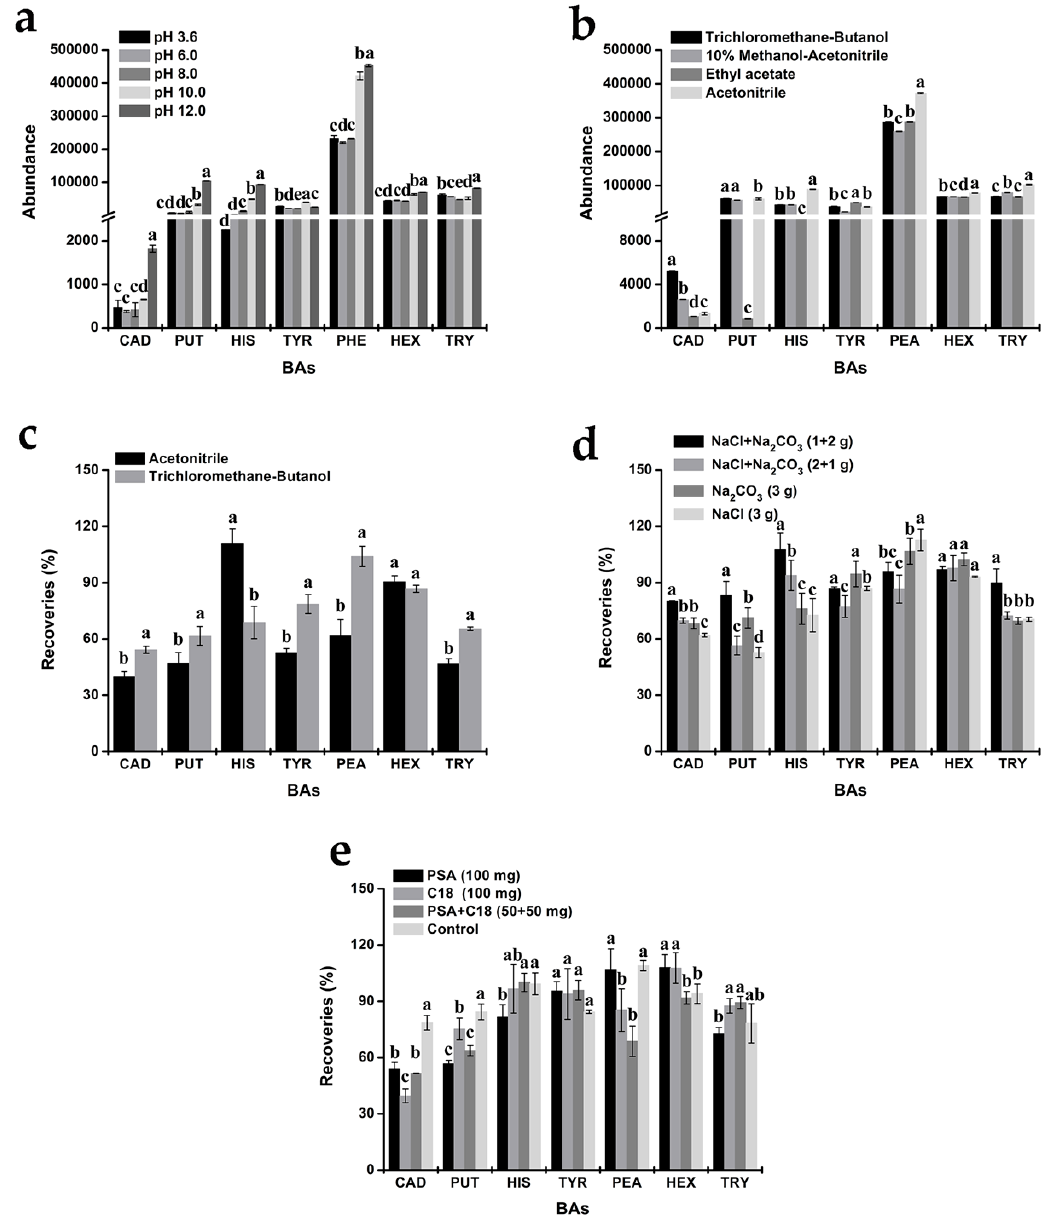
Figure 3. Abundance and recoveries obtained by different QuEChERS procedures ( a ). the pH optimization; ( b ). the extraction solvent optimization; ( c ). the recovery percentage obtained by applying acetonitrile and trichloromethane-butanol solutions; ( d ). the amount and type of salt optimization; ( e ). the clean-up optimization; different letters in same BA are statistically significant p < 0.05; CAD: Cadaverine; PUT: Putrescine; HIS: Histamine; TYR: Tyramine; PEA: Phenylethylamine; HEX: Hexylamine; TRY: Tryptamine). An ideal sample pretreatment way is to use a simple extraction method to distribute the target objects in the extracting solution as much as possible. The extraction e ff ects of acetonitrile, ethyl acetate, trichloromethane-butanol (1:1, v / v ), and 10% methanol-acetonitrile ( v / v ) were compared in this experiment. By comparing the peak abundance of the seven kinds of BAs, it was found that acetonitrile and trichloromethane-butanol solutions demonstrated better overall extraction e ffi ciency for seven BAs, which assumed significant di ff erence from other extraction agents (Figure 3b). Meanwhile, on the basis of the above optimized conditions, the recoveries of the seven BAs by acetonitrile and trichloromethane-butanol were further measured. It could be clearly observed from Figure